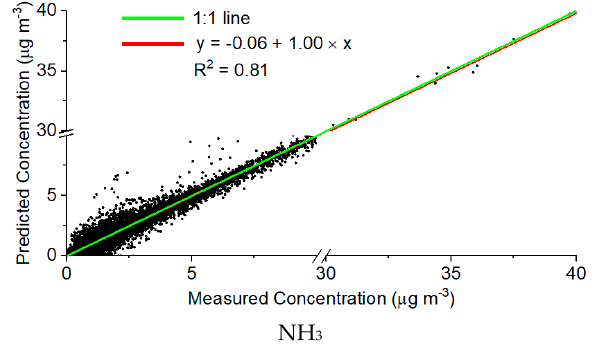
Figure 3. The ratios of C p /C o for HNO 3 prediction using stable and metastable model setups.